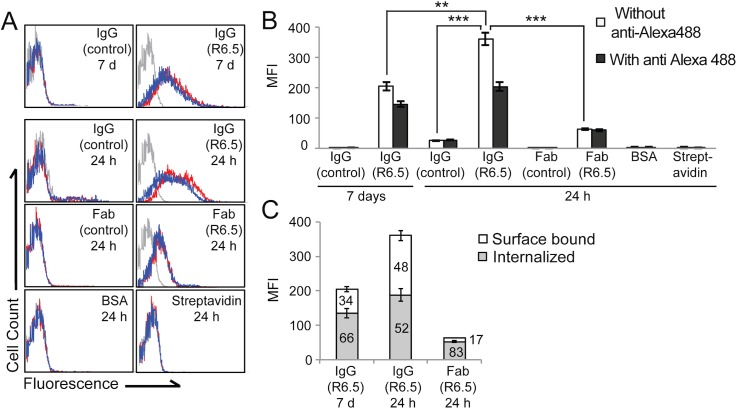
Specific interaction is required for cell binding and internalization.(A) Singlet cells from HeLa tumor were analyzed by flow cytometry with (histograms in blue line) or without (histograms in red line) incubation with anti-Alexa488 antibodies. Background fluorescence is shown in gray histogram. The top two histograms are for the tumors analyzed after 7 days postinjection of imaging agents, while the remaining six are for the tumors analyzed after 24 h postinjection of imaging agents. (B-C) Quantification of mean fluorescence intensity and fractions of surface bound versus internalized imaging agents are shown in bar graphs as mean ± SEM (n = 3; **p < 0.01, ***p < 0.001). The numbers represent the percentage values.